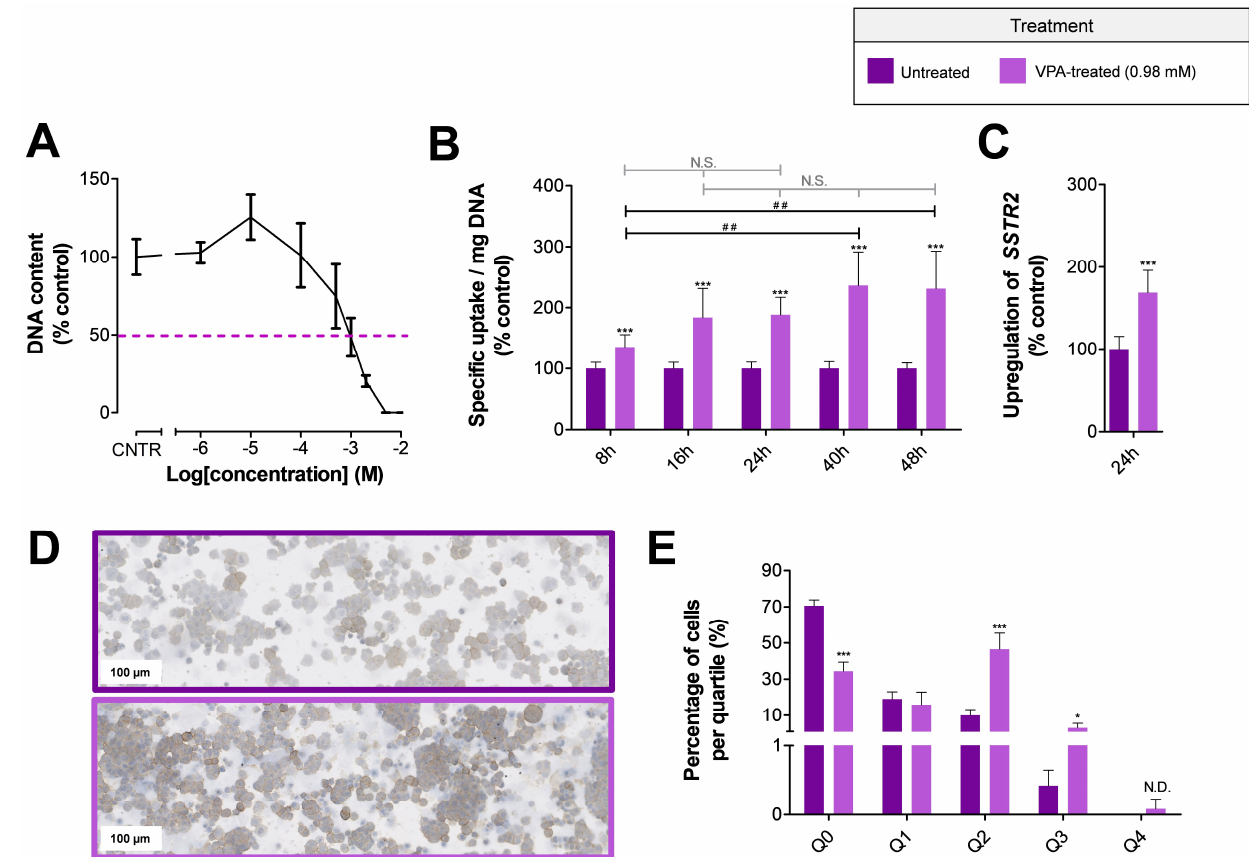
Figure 1. In vitro effects of VPA on SSTR2 expression The IC 50 value of VPA in NCI-H69 cells was 0.98 mM ( A ). To study the effect of VPA on SSTR2 expression, the uptake of [ 111 In]In-DOTATATE (per milligram DNA, expressed as percentage of control cells) ( B ), SSTR2 mRNA expression levels (ex- pressed as percentage of control cells) ( C ) and SSTR2 protein expression levels ( D , E ) were examined. The percentage of SSTR2 negative cells (Q0) and the extent of SSTR2 intensity (Q1–Q4) were deter- mined. To indicate significance for t -test results between vehicle- and VPA-treated cells, the following abbreviations and symbols were used: * p < 0.05; *** p < 0.001 and N.D. = non-determined (due to ab- sence of vehicle-treated cells in Q4). For the one-way ANOVA results between different VPA-treated groups, the following abbreviations and symbols were used: ## p < 0.01 and N.S. =